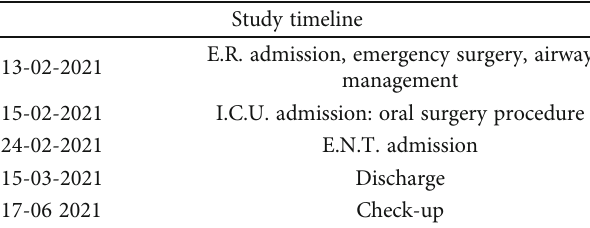
Figure 7: (a – f) Extraction of 1.7 (a, b); extraction of 4.7 plus pontic (c, d); extracted 1.7 (e) and 4.7 (f). Table 2: Data regarding the patient